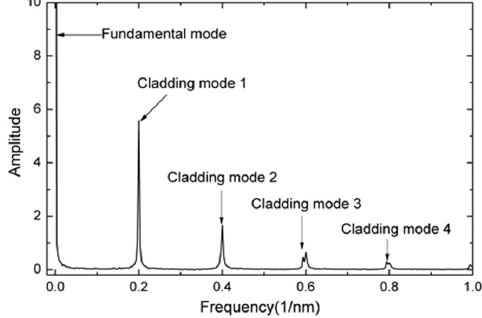
Figure 3. Spatial frequency spectrum of the MFI.